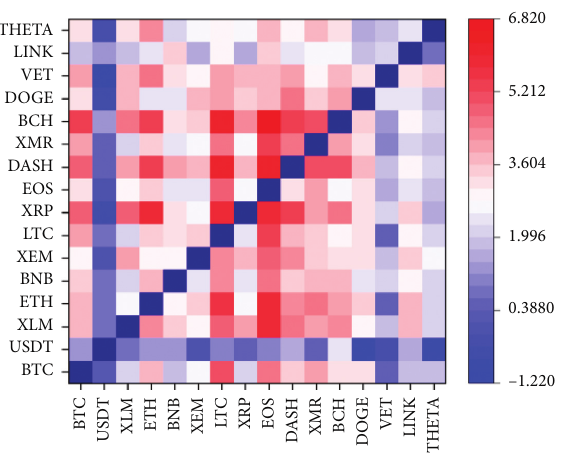
Figure 5: Causality test under D4.